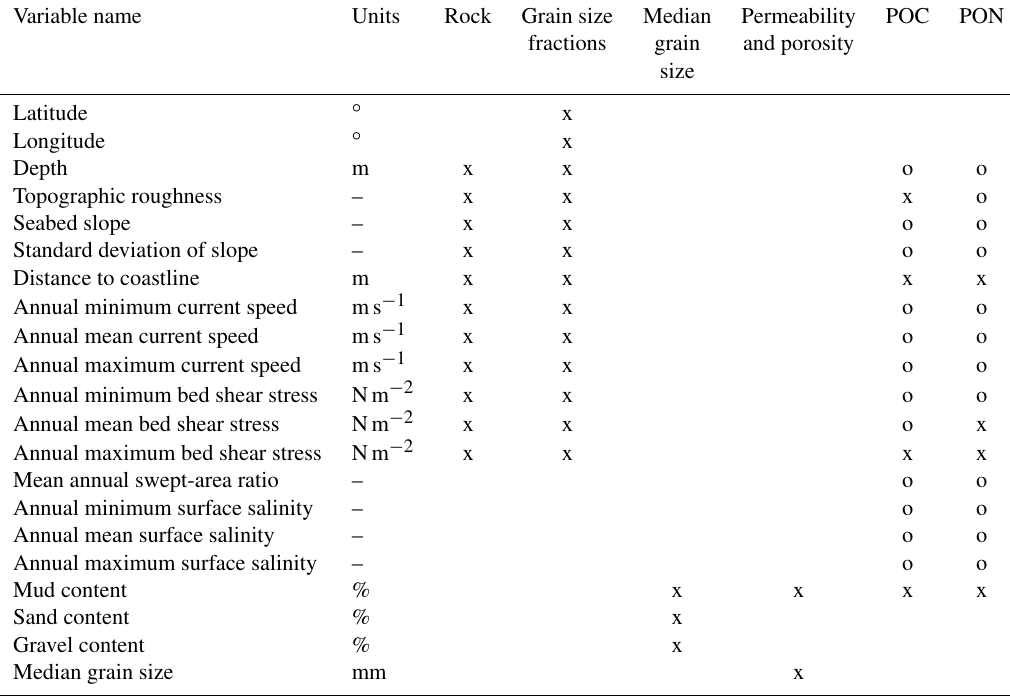
Table 2. Explanatory environmental variables used to predict seabed physical properties and particulate organic carbon (POC) and nitrogen (PON) content. For each predicted sedimentary property, the explanatory variables used are listed (x). In addition, for properties where model selection was carried out, the explanatory variables that were evaluated but not retained in the optimal model are also listed